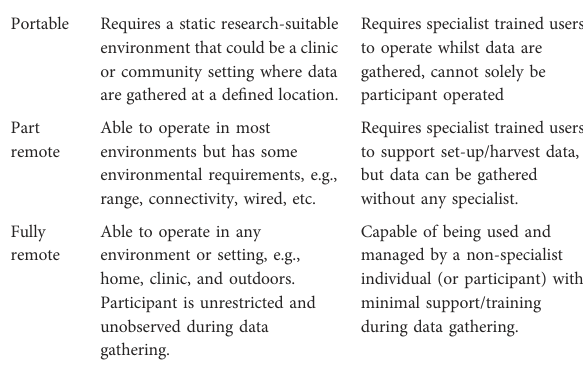
TABLE 2 De fi nition terms for degree of technology